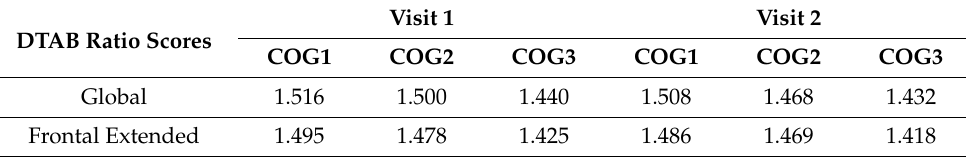
Table 6. DTAB Ratio